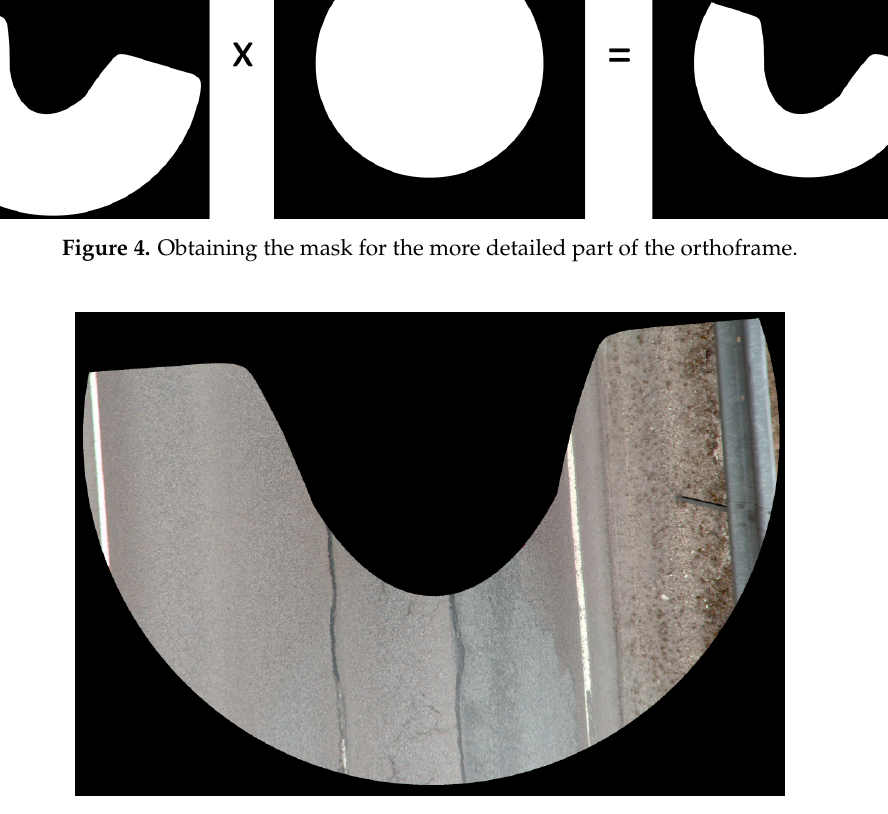
Figure 5. Due to the decreased area of interest, non-road surface is present only at the right side of the